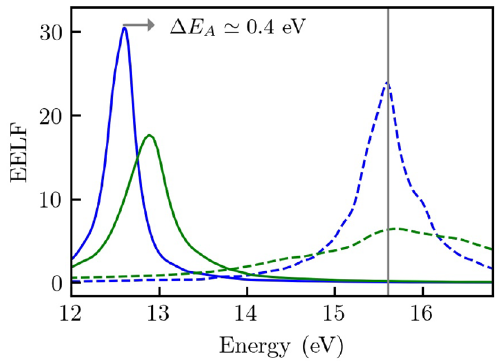
Figure 6. The EELF for aluminum at U 0 = 0.5 , q = 0.34 Å − 1 at temperatures T = 1.25 eV (solid blue) and T = 6.27 eV (solid green). The EELF of the unperturbed aluminum (dashed) is shown for comparison.